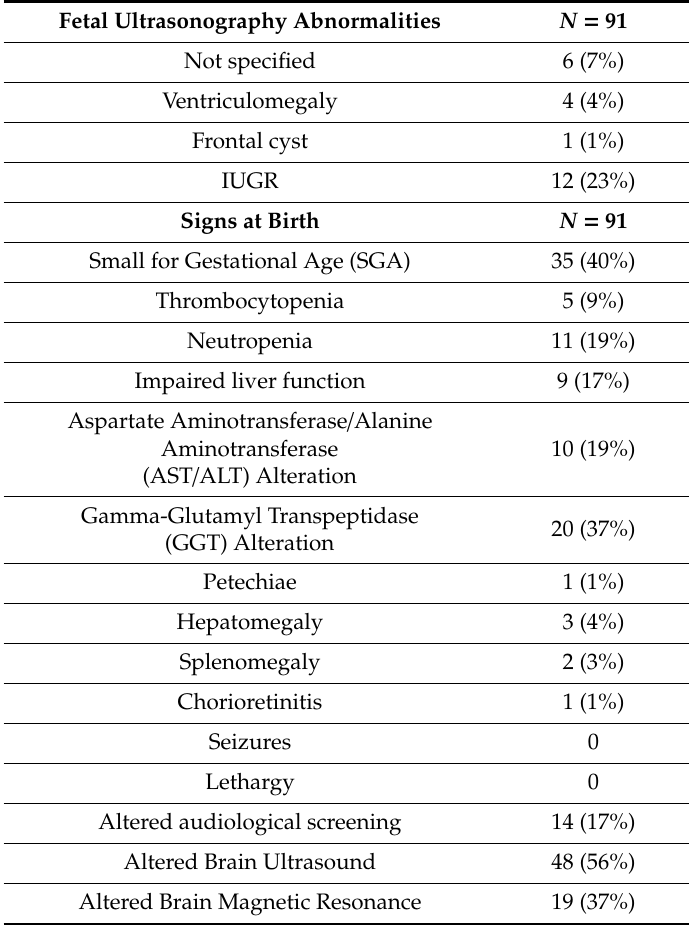
Table 3. Fetal and neonatal infection